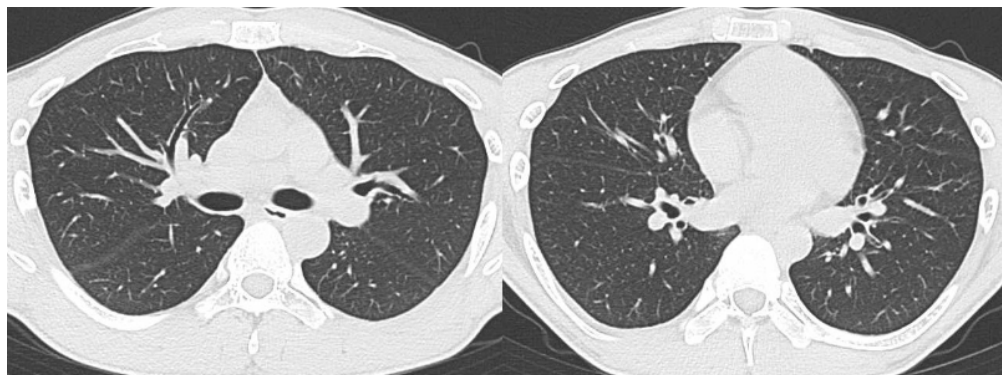
Figure 8. Example of a false-negative case. Twenty-five-year-old male. Although RT-PCR was positive for SARS-CoV-2, the CT images show no abnormal findings. All readers diagnosed it as Category 1. CT, computed tomography; RT-PCR, reverse transcription-polymerase chain reaction; SARS-CoV-2, severe acute respiratory syndrome coronavirus 2.